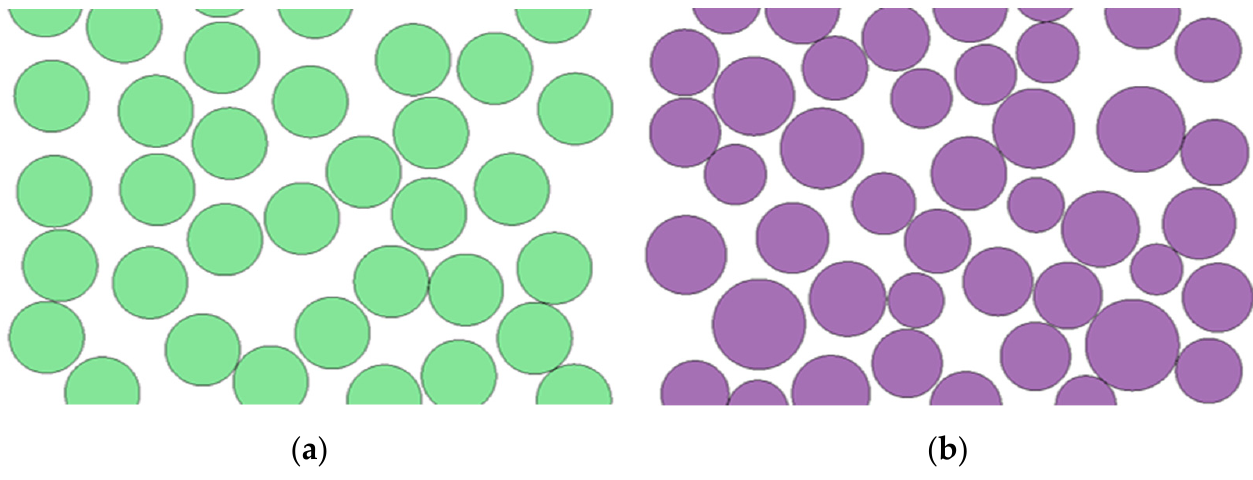
Figure 10. Shots with constant diameter ( a ), and variable diameter ( b ).